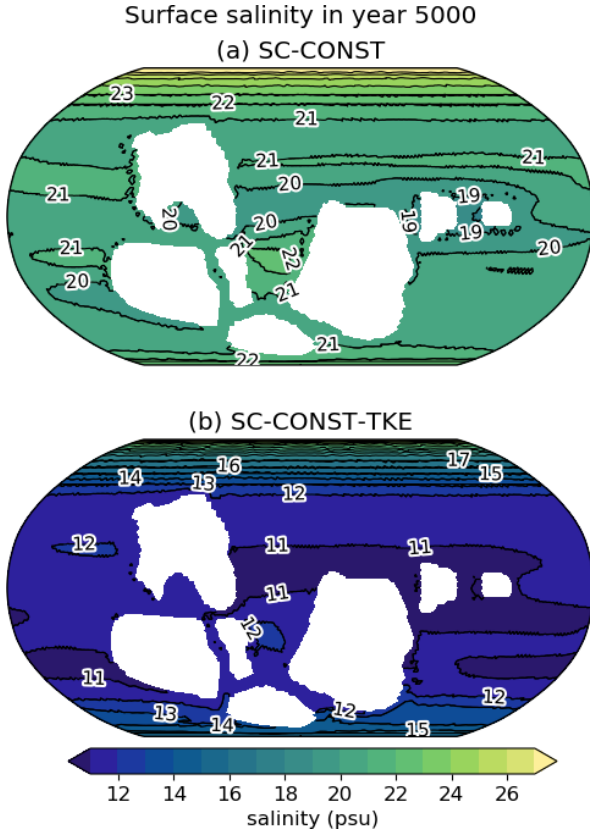
Figure 7. Surface salinity in year 5000 of (a) SC-CONST and (b) SC-CONST-TKE. The latter uses the parameters of the TKE vertical mixing scheme as they were suggested in Gaspar et al. (1990). The data in both plots represent a 30-year mean around the specified